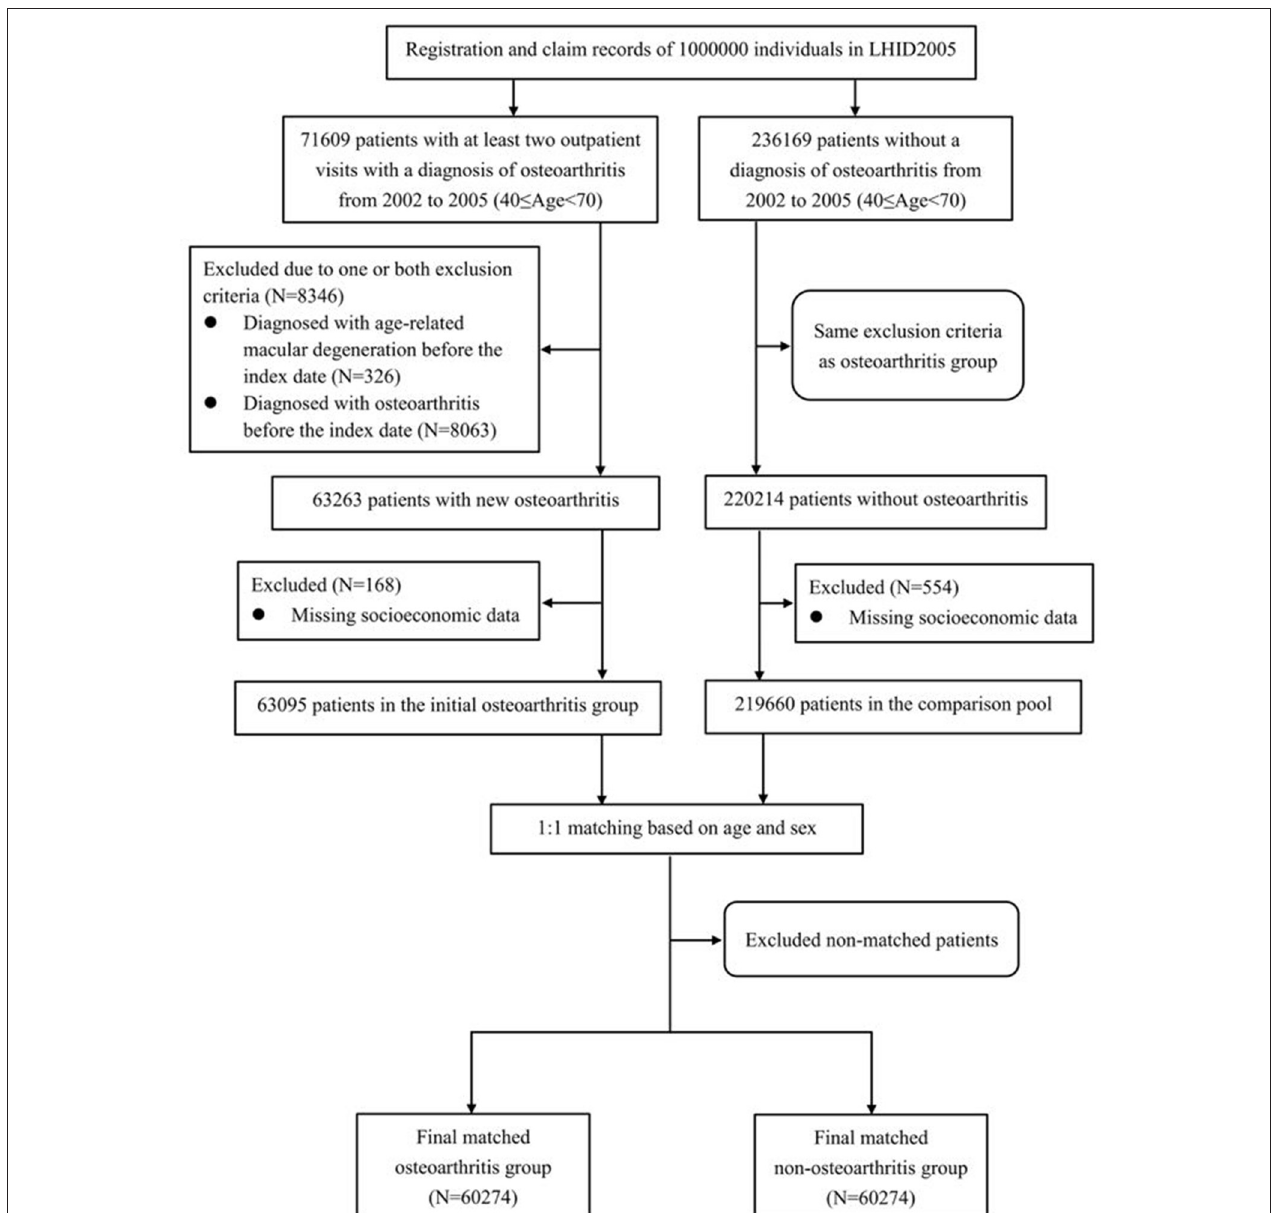
FIGURE 1 | Flowchart illustrating the enrollment process of the osteoarthritis and non-osteoarthritis groups.